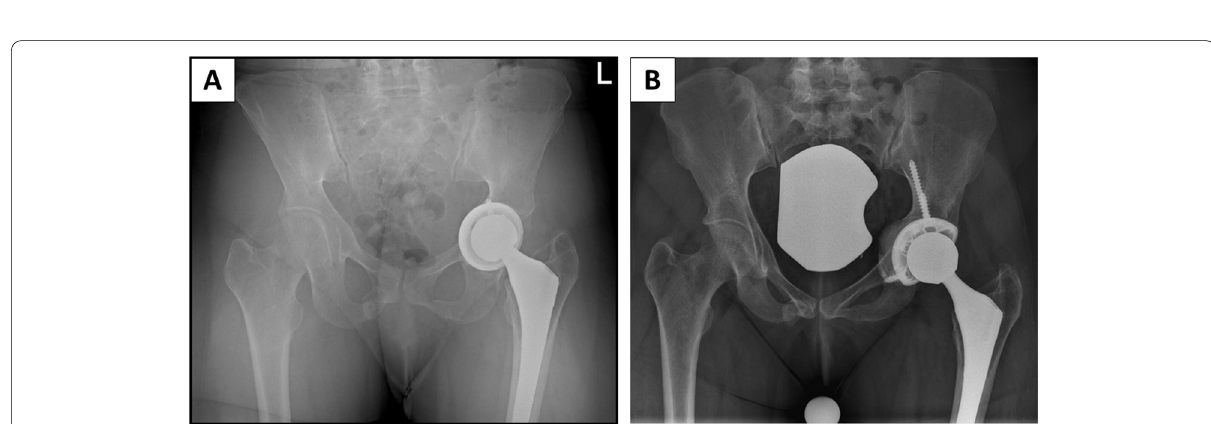
Fig. 3 Revision THA: A Preoperative pelvis AP radiograph of 72 y/o female with pelvic discontuity and protruded primary acetabular shell. B Postoperative AP pelvis radiograph of fully porous cup with cemented XLPE liner and two locking